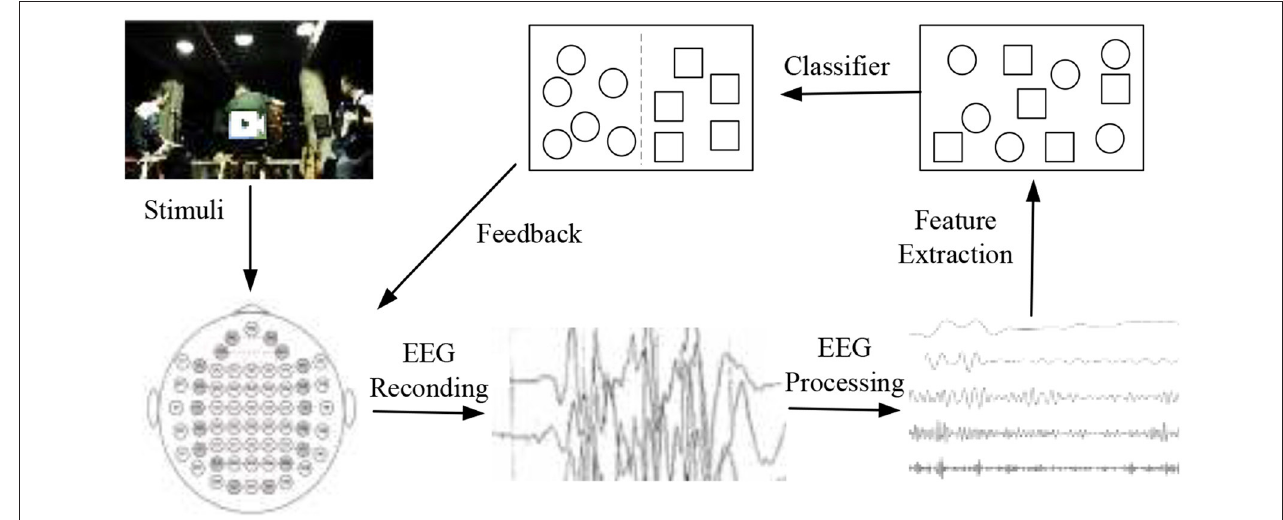
FIGURE 1 | The illustration of EEG-based emotion classification in